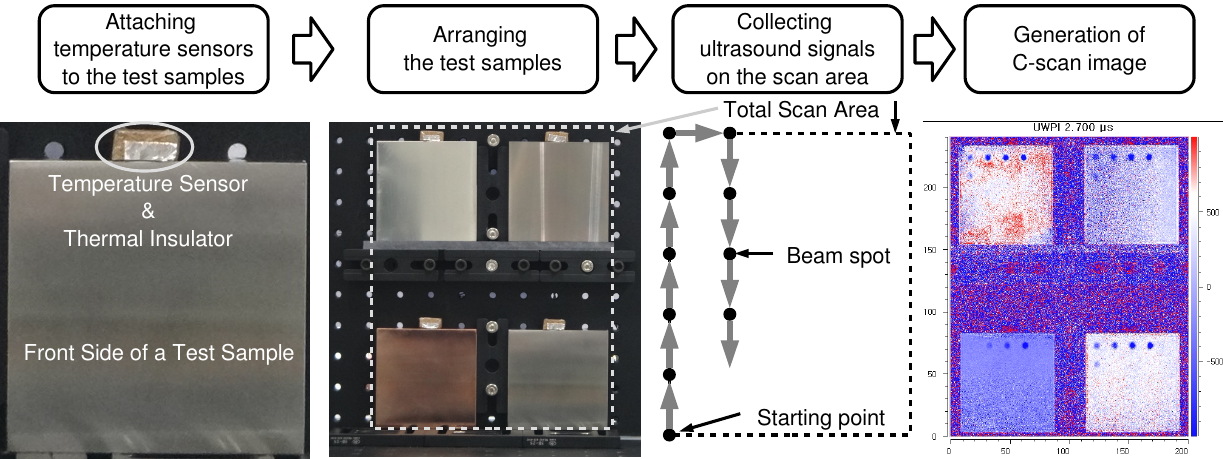
Figure 1. Ultrasound generation and detection with the laser FF PE UPI system: ( a ) ultrasound generation using a pulse laser beam and ( b ) detection of the vibrations by a continuous laser beam.